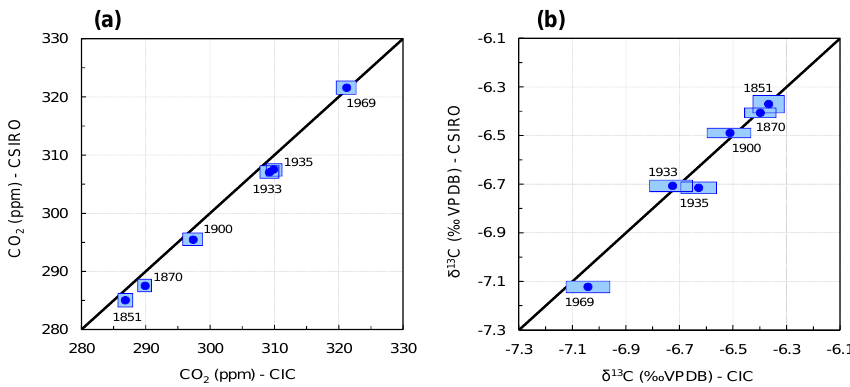
Figure 7. Laboratory intercomparison measurements between CIC and CSIRO of Law Dome ice core samples covering the recent past (1851–1969AD). CO 2 mixing ratios (a) and δ 13 C-CO 2 values (b) measured at CIC ( x axis) and CSIRO ( y axis; Rubino et al., 2013) are shown. Blue boxes indicate 1 σ uncertainties defined for each laboratory by the respective side